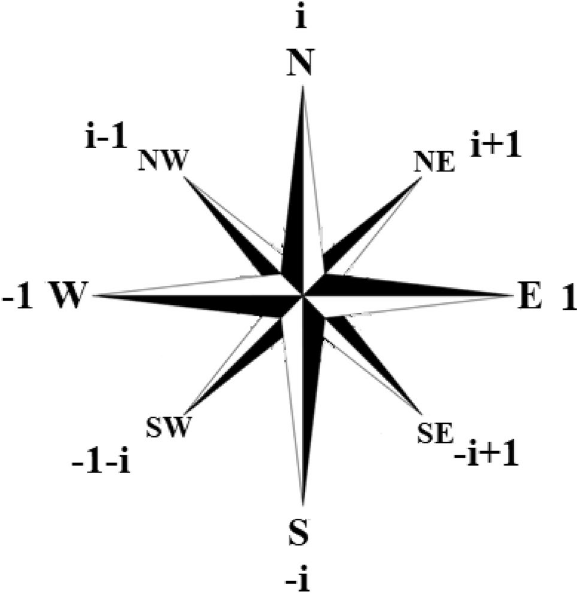
Figure 1. 8-wind compass rose (Image was generated in Paint 22H2 https:// apps. micro soft. com/ store/ detail/ paint/ 9PCFS 5B6T7 2H? hl= ru- ru& gl= ru).